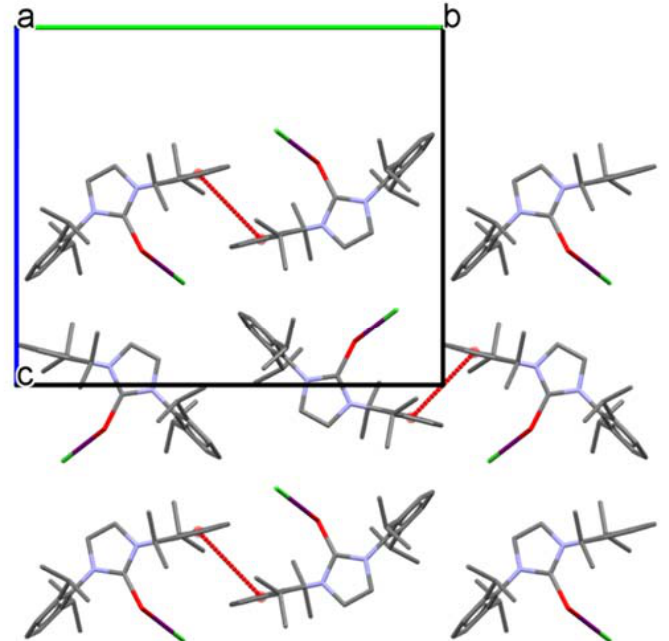
Figure 4. Packing in the crystal structure of Compound 5 viewed down the a-axis with the shortest π - π interactions (4.089(5) Å) indicated, i.e., between 2,6-diisopropylphenyl ring centroids and their symmetry-equivalents. Hydrogen atoms and solvent molecules are omitted for clarity.